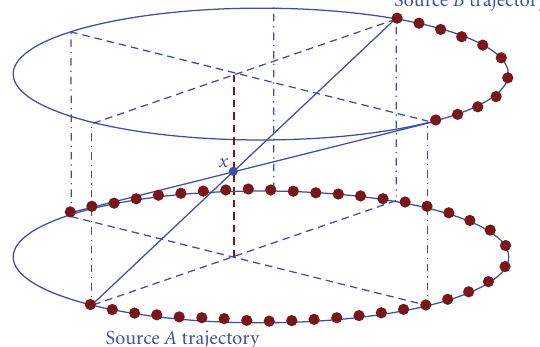
Figure 6: View contributions from source A and source B to a given reconstruction point x